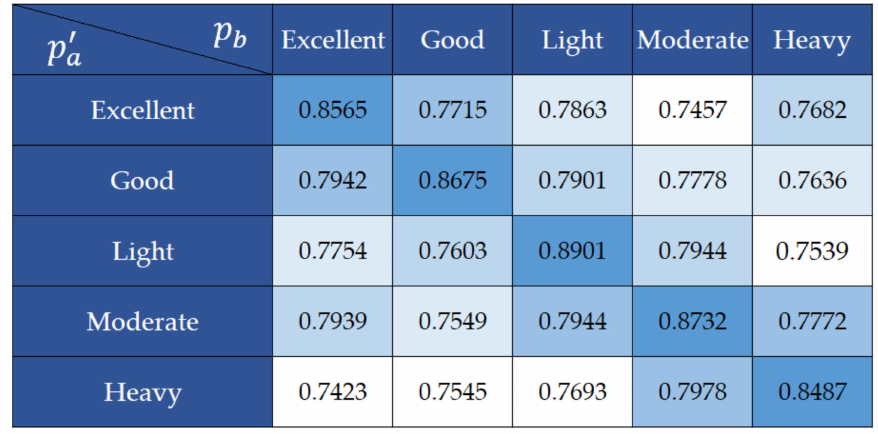
Figure 16. Color similarity between reference images and corrected matching